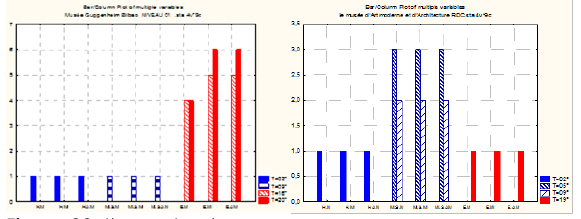
Figure 09 : the route